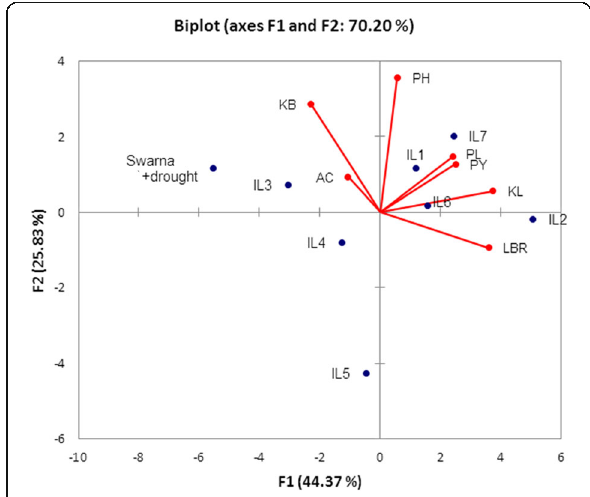
Fig. 5 Principal component analysis of ILs PCA of ILs for different grain quality traits (KL, KB, LBR, AC) and agronomic traits (PH, PL, PY) during WS2018 showed that IL1, IL6 and IL7 with different genes/ QTLs combination perform better than recurrent